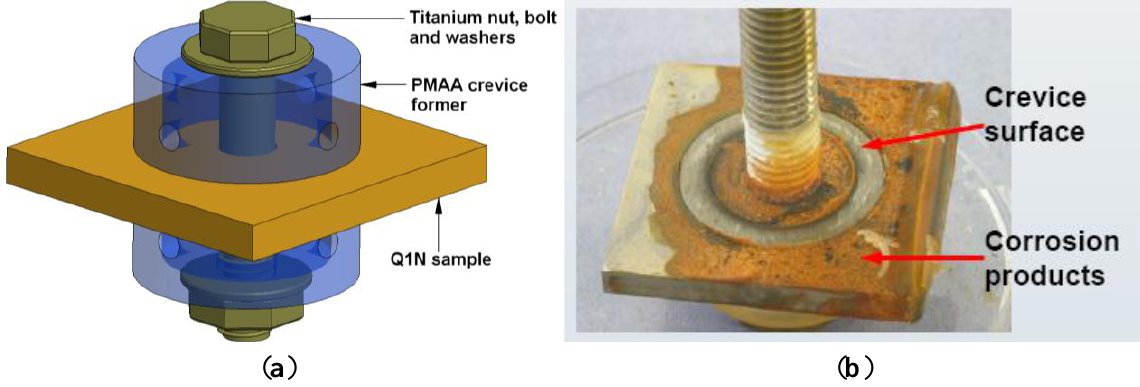
Figure 2. Schematic of ( a ) a Cortest crevice corrosion assembly; and ( b ) crevice corrosion sample of Q1N after immersion in 3.5% NaCl solution for 24